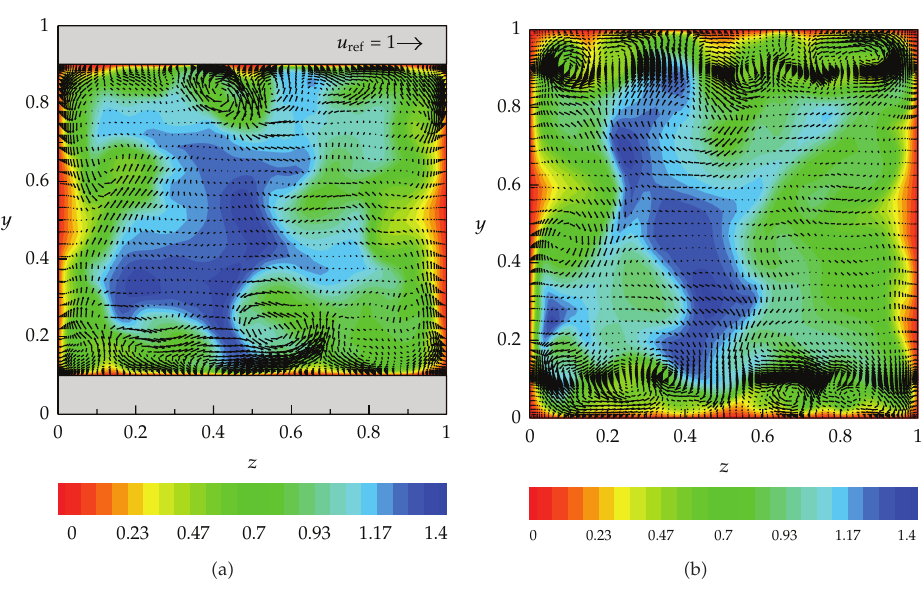
Figure 4: Instantaneous velocity vector superimposed on temperature contours on cross-planes (cid:2) a (cid:3) x (cid:8) 0 . 5 and (cid:2) b (cid:3) x (cid:8) 1 .